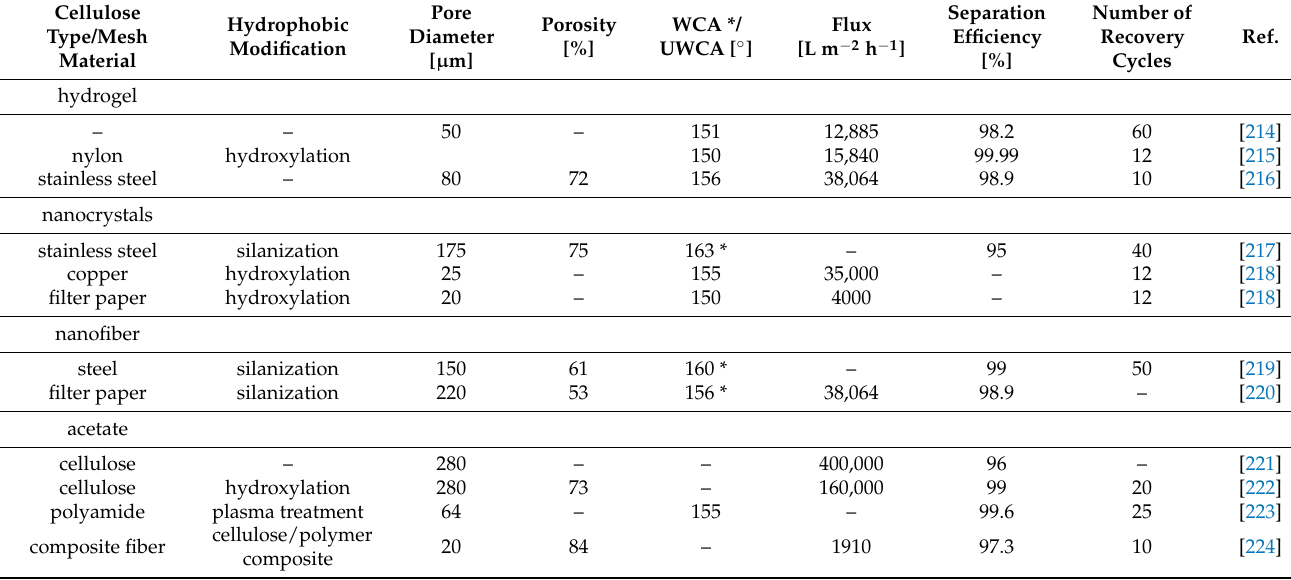
Table 5. Cellulose coated mesh for oil removal (values are marked with * if it is the WCA; otherwise the UWCA is reported). Cellulose Type/Mesh